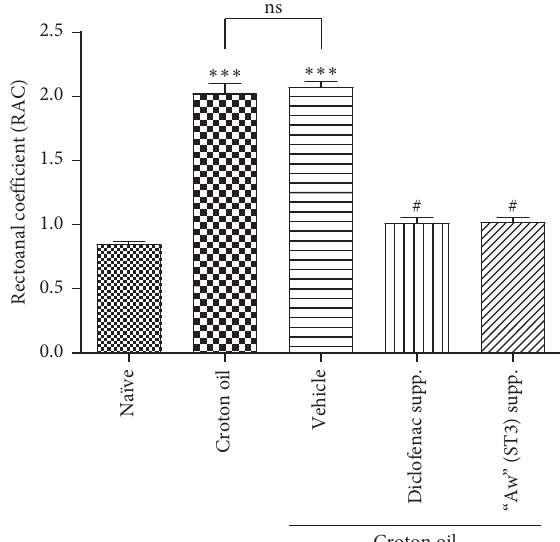
Figure 9: Effect of various treatments on the rectoanal coefficient in croton oil-induced hemorrhoids in rats. Data were expressed as mean ± SEM. ns � not significant, ∗∗∗ P < 0 . 001 when compared to naive and # P < 0 . 05 when compared to vehicle using Kruskal–Wallis nonparametric one-way ANOVA followed by Dunn’s post hoc test ( n � 5).